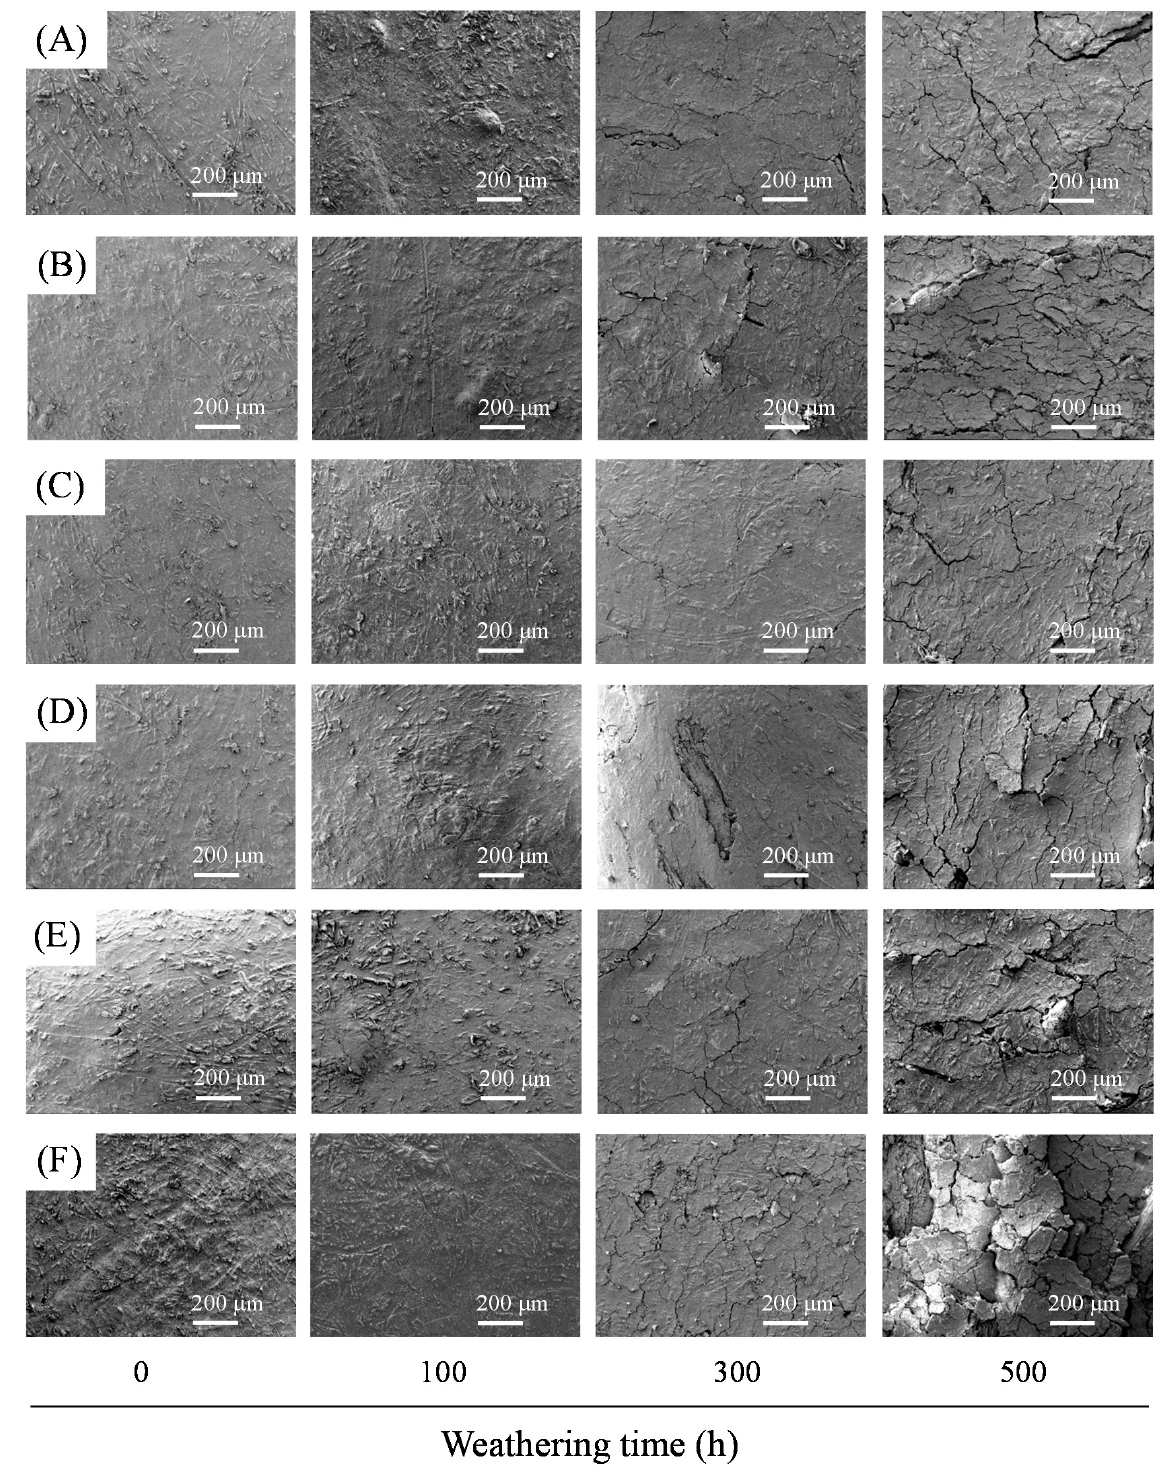
Figure 3. SEM micrographs of various WPCs before and after xenon arc accelerated weathering for 100, 300, and 500 h. ( A ) WPC B20 , ( B ) WPC R20 , ( C ) WPC S16 , ( D ) WPC S20 , ( E ) WPC S30 , and ( F ) WPC S60 .